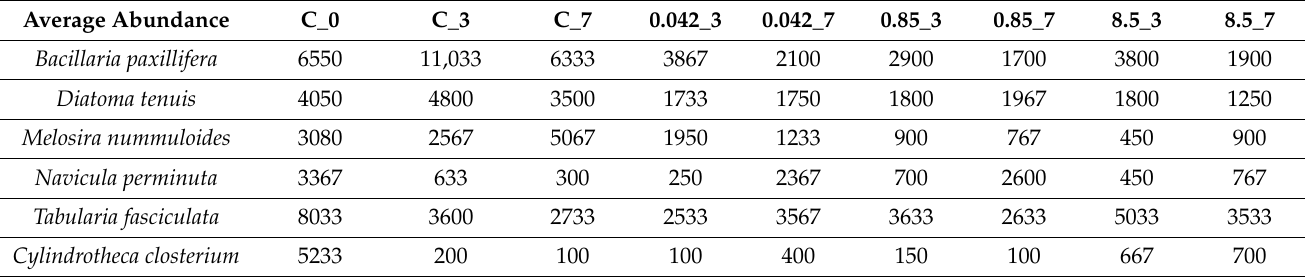
Table 2. Average abundance and standard deviations of selected